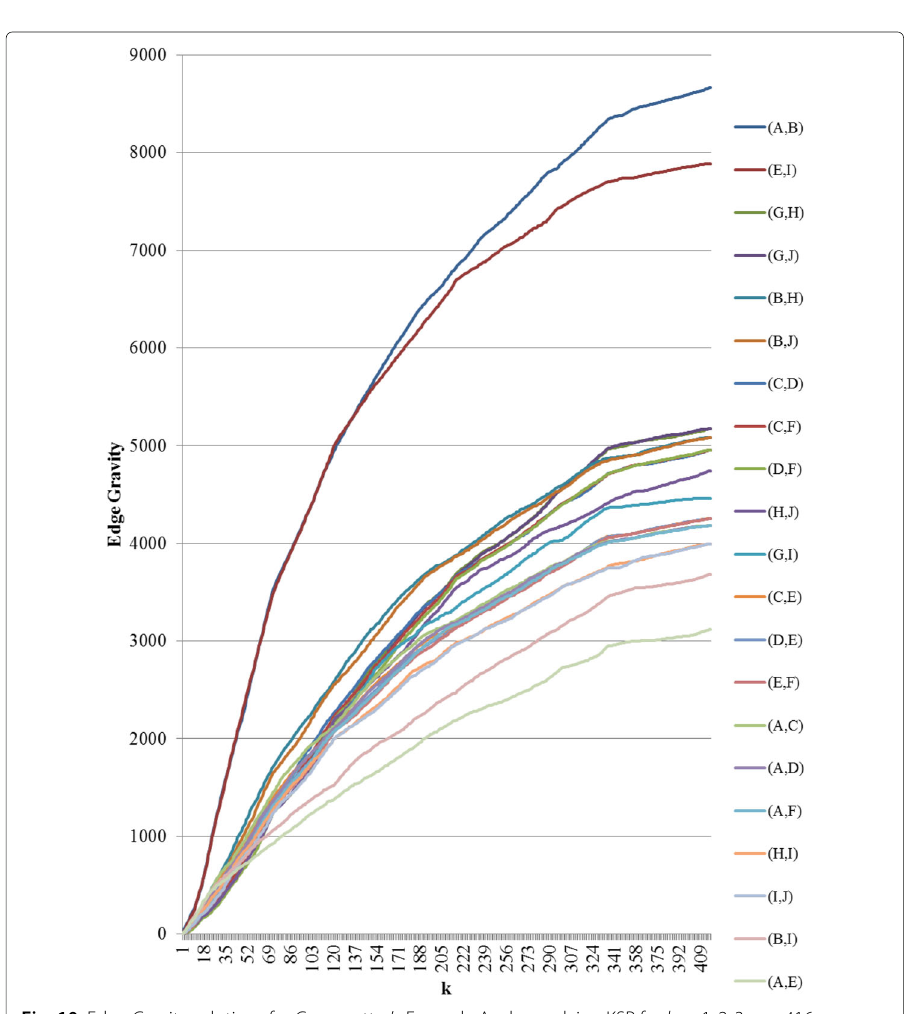
Fig. 10 Edge Gravity solutions for Granovetter’s Example A when solving KSP for k = 1,2,3, ... ,416